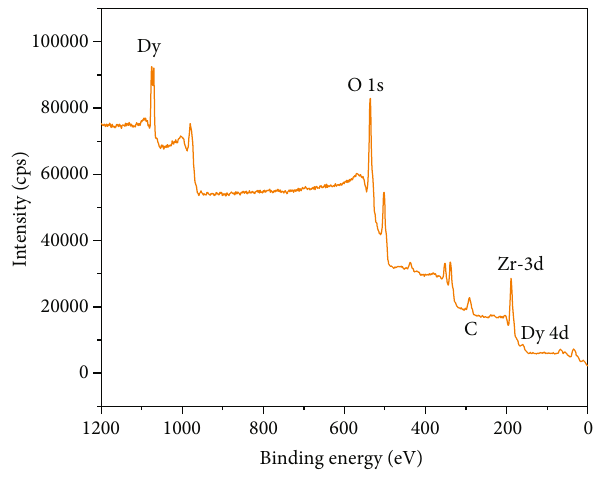
Figure 6: XPS spectra of Dy-doped (3 mol%) ZrO+ NPs.